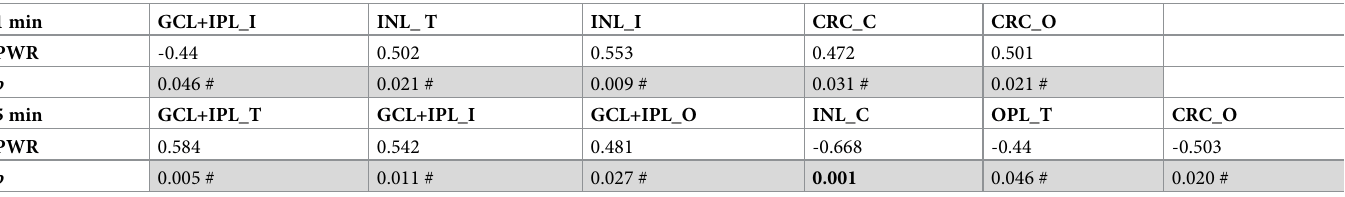
Table 4. Correlation between the performance (maximal power-to-weight ratio expressed as watt/kg) and the layer thickness changes at 1 and 5 minutes of the recovery period for the total retina and three macular areas (T, total macula, C, central subfield, I, inner ring, O, outer ring).